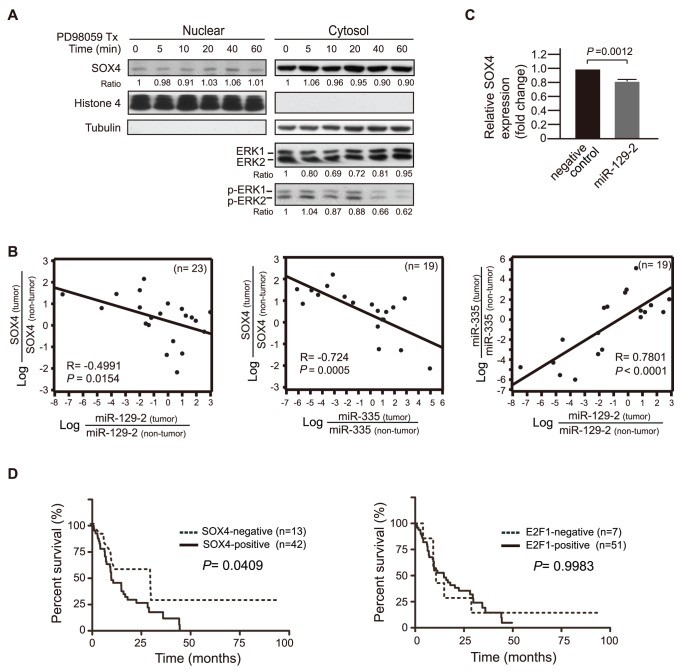
Co-repressed miR-129-2 and miR-335 are associated with expression of SOX4, which correlates with shorter survival in patients with pancreatic cancer.(A) time-course change of ERK1/2 phosphorylation and the cytoplasm-nucleus distribution of SOX4 after PD98059 treatment. The whole cell lysates at the indicated time after treatment with 20 µM PD98059 were subjected fractionation, resolved by SDS-PAGE, and immunoblotted with the indicated antibodies. At 40 min after PD98059 treatment when ERK1/2 phosphorylation was inhibited, no difference was observed in the total amount of SOX4 protein, or the cytoplasm-nuclear distribution of SOX4. (B) Left and Central plots: Strong inverse correlation between miR-129-2 expression/miR-335 expression and SOX4 expression in PDAC cases as analyzed by Pearson correlation with log transformation for normality in scatter plots. n, the number of cases analyzed; Negative value in R indicates inverse correlation between X- and Y-variables. Right plot: the expression level of miR-335 in pancreatic carcinoma samples is positively correlated with the level of miR-129-2 in a linear regression way. (C) Marginal effect on suppressing SOX4 expression by transient transfection of miR-129-2 in PANC-1 cells as assessed by quantitative real-time PCR analysis in triplicate using a paired t-test. (D) Kaplan-Meier curves were shown as a function of SOX4 or E2F1 immunohistochemistry. Left: SOX4 expression in human PDAC correlates with shorter patient survival. Right: E2F1 expression did not correlate with patient survival. The P-value corresponds to the log-rank test by comparing the survival curves.